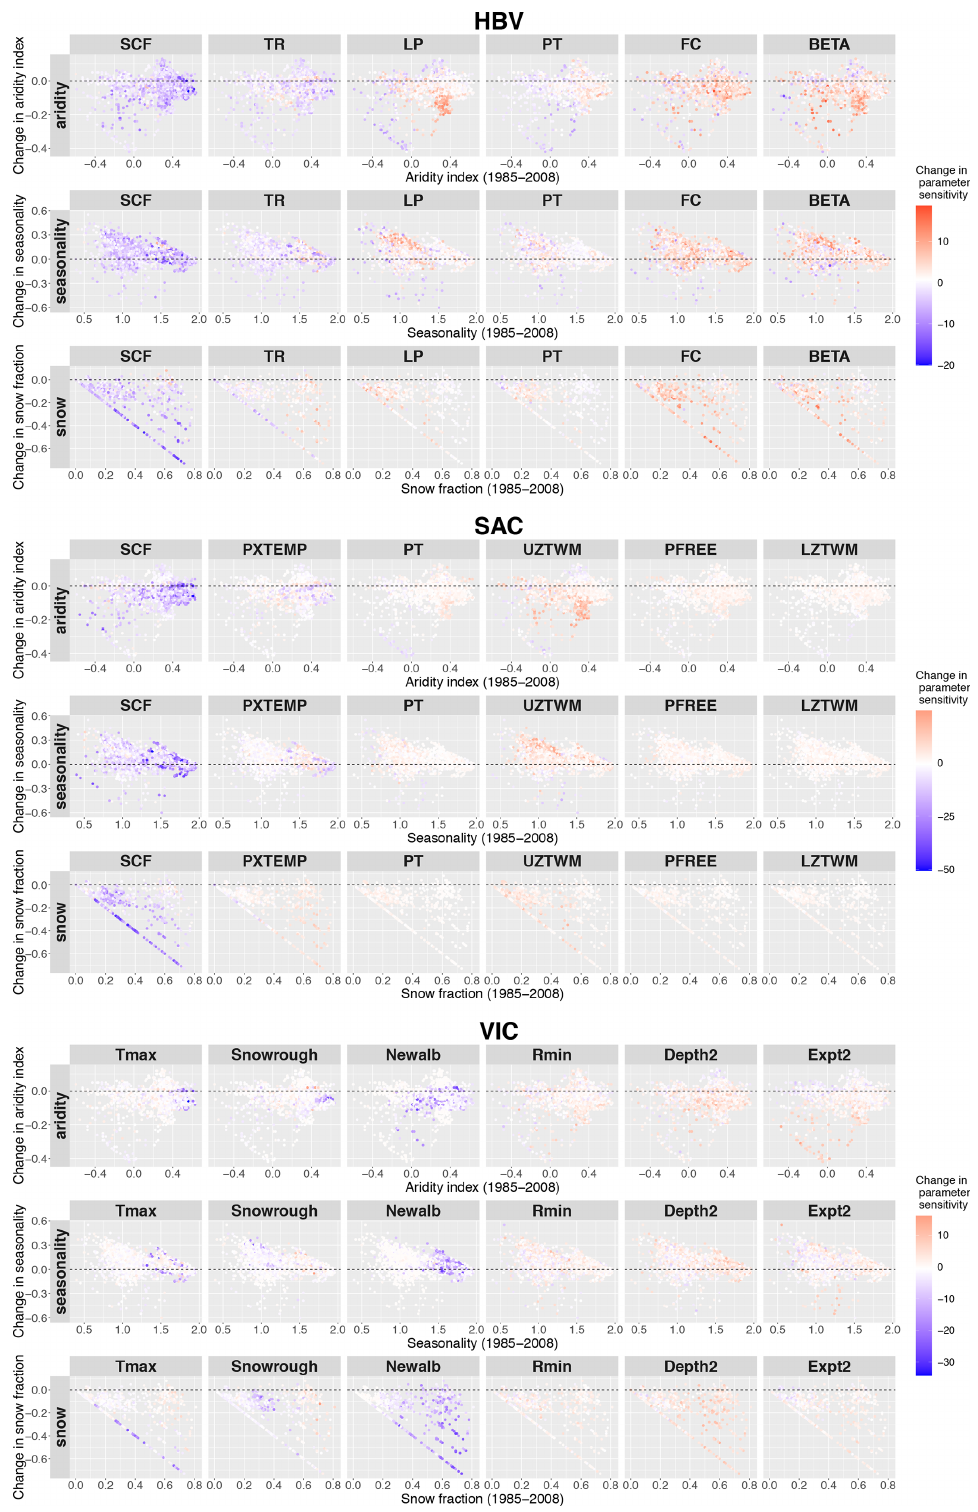
Figure C2. Change in parameter sensitivity vs. historical climate indicators and change in climate indicators for 605 basins using discharge timing as the target variable. All three climate scenarios are shown in the plots. The climate indicators are aridity index ( − 1 highly arid, + 1 highly humid), seasonality, and fraction of precipitation falling as snow, as defined by Knoben et al. (2018). Parameter sensitivity for the historical period is expressed in dot size, change in parameter sensitivity in colour: red indicates an increase in sensitivity, blue a decrease.